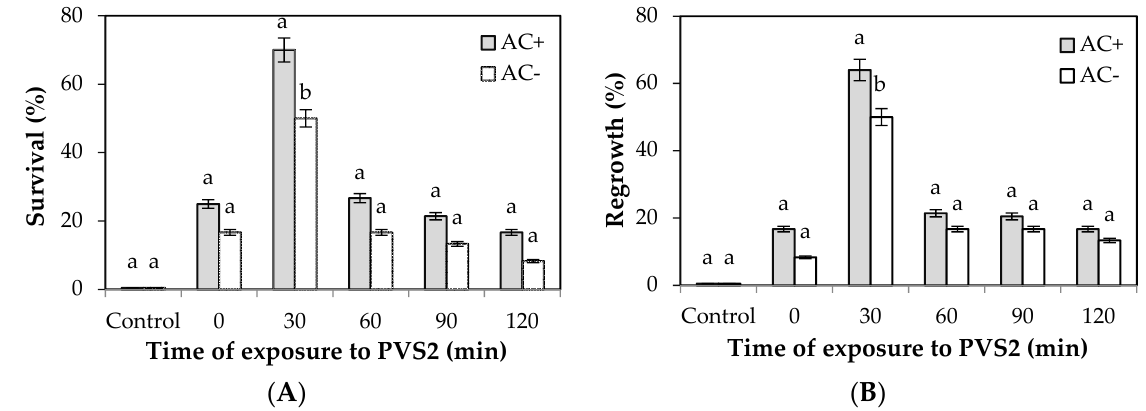
Figure 2. Effect of activated charcoal on the survival ( A ) and regrowth ( B ) of cryopreserved (LN+) chestnut embryonic axes by encapsulation–vitrification. EAs were encapsulated in WPM solution containing 2.5% ( w / v ) sodium alginate with (AC+) or without (AC − ) 0.3% ( w / v ) activated charcoal in the artificial matrix. Encapsulated EAs were treated for 60 min with LS (2.0 M glycerol, 0.4 M sucrose), followed by treatment with PVS2 at 0 °C for 30–120 min, prior to direct immersion in liquid nitrogen for 1 h. Control EAs received no LS and PVS2 treatments. Within each exposure time, different letters indicate significant differences between AC+ and AC − at p ≤ 0.05 by chi-squared test (bars, SE of means).